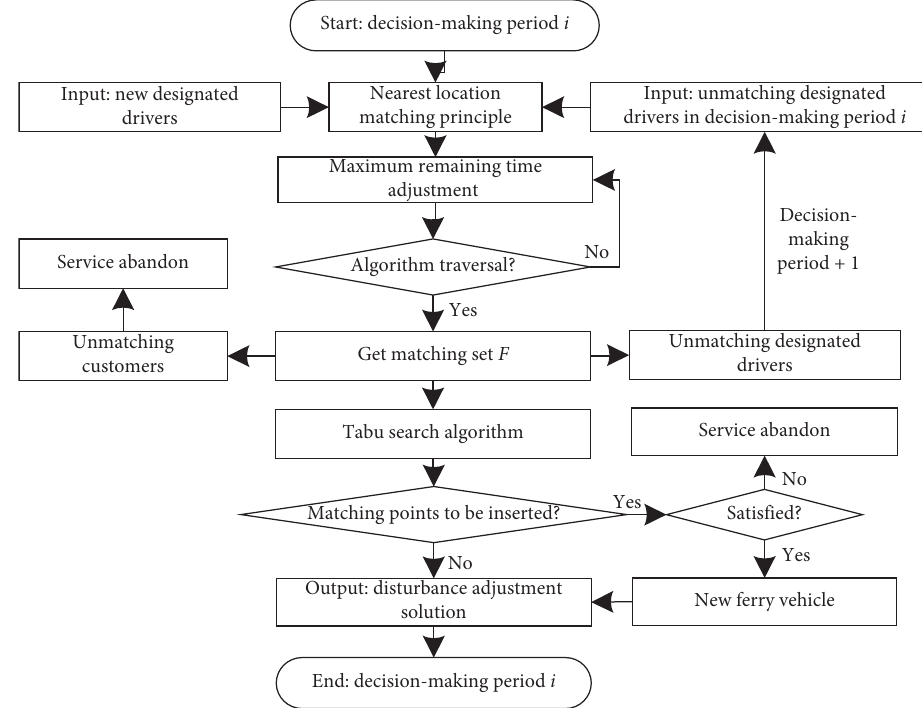
Figure 3: A flowchart of the